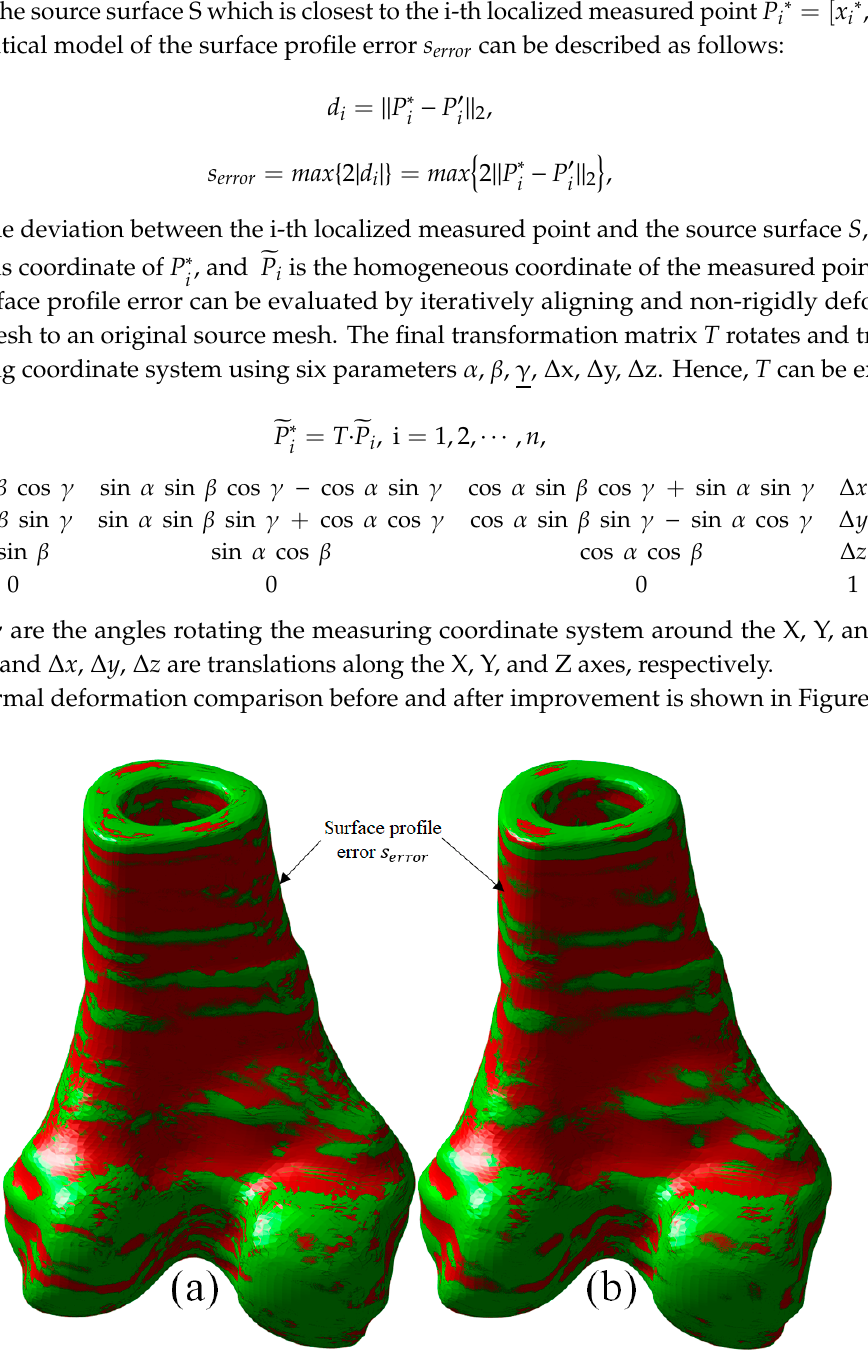
Figure 6. Thermal deformation comparison before and after improvement where ( a ) is regarding i -th step iteration and ( b ) is regarding ( i+ 1)-th step